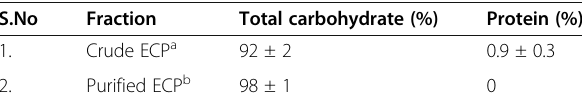
Table 1 Carbohydrate and protein contents of crude and pure